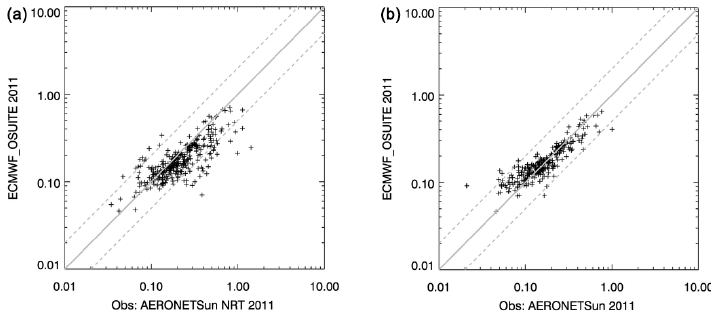
Figure 8. Retrospective evaluation of MACC o-suite for 2011, using NRT Aeronet level 1.5 data (top) and quality assured Aeronet level 2.0 data